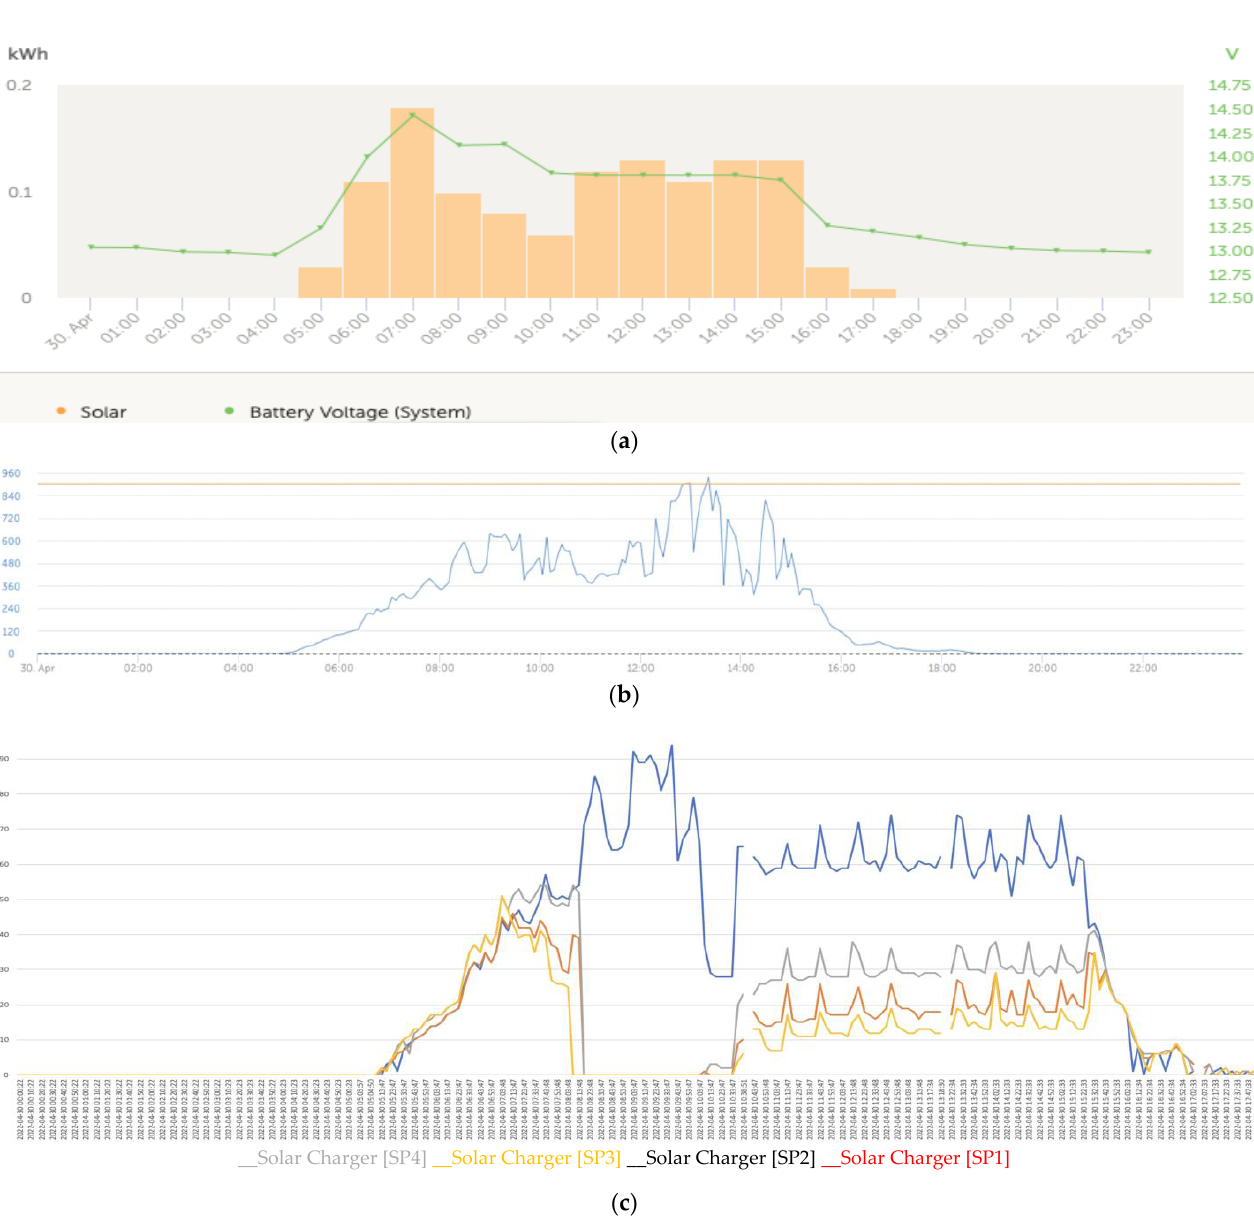
Figure 18. ( a ) Daily charge phases: initial, absorption, and flotation (30 April). ( b ) Solar irradiance (30 April). ( c ) Deviation trend comparative PV power data series analysis due to partial shading (30 April).